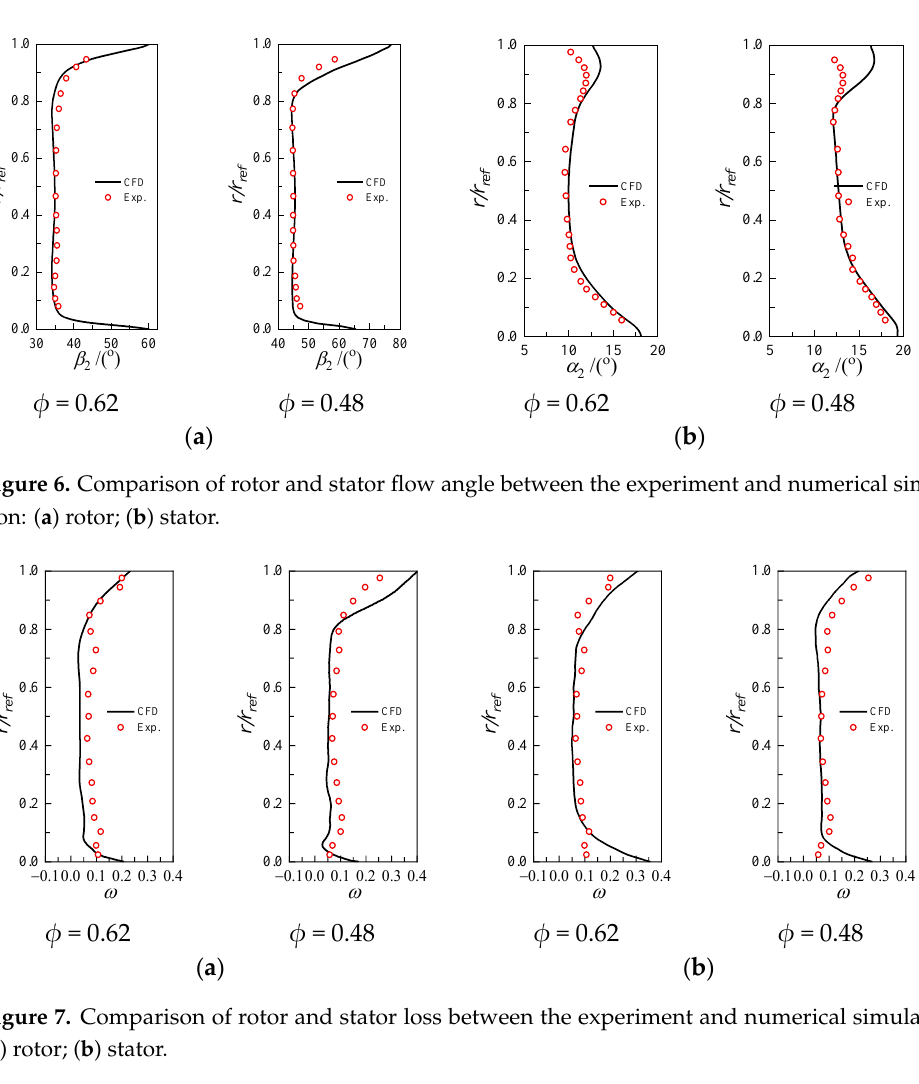
Figure 6. Comparison of rotor and stator flow angle between the experiment and numerical simu- lation: ( a ) rotor; ( b ) stator.